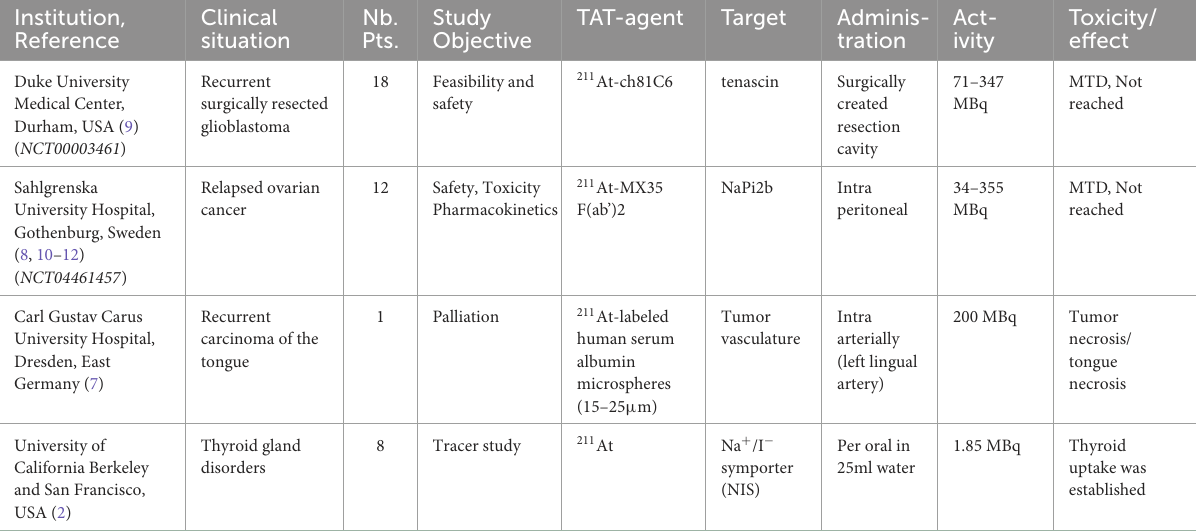
TABLE 1 Completed clinical studies using 211 At. ( NTC number ) is the ClinicalTrials.gov identifier. Institution,